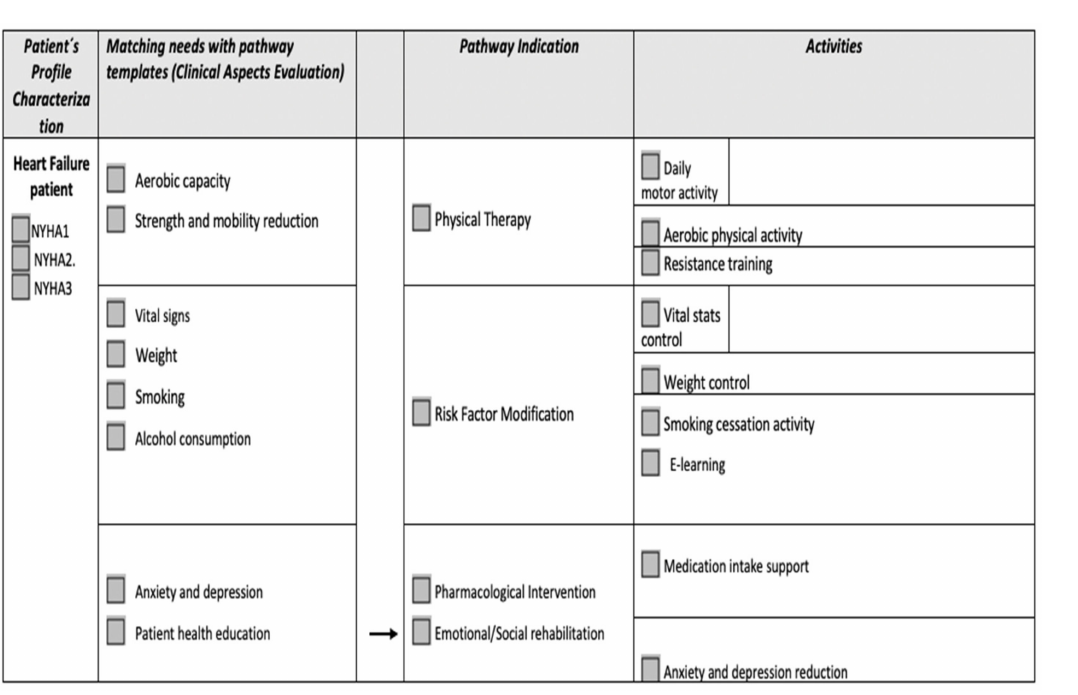
Figure 1. Available pathways for heart failure patient.